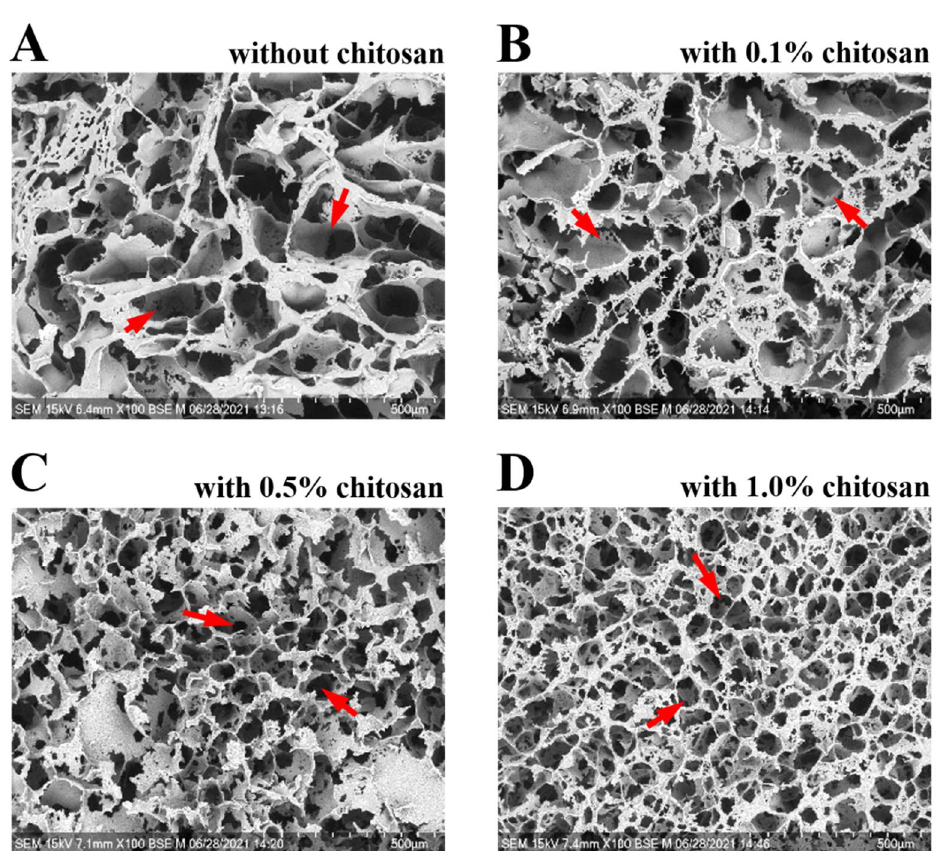
Figure 3. SEM images of pea-based tofu ( A ) without chitosan, ( B ) with 0.1% chitosan, ( C ) with 0.5% chitosan, and ( D ) with 1.0% chitosan. Red arrow: gel pore.